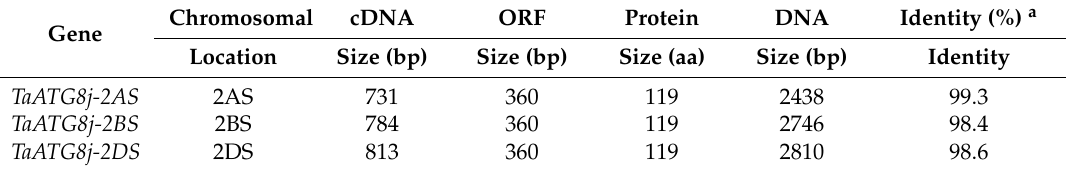
Table 1. Three copies of TaATG8j in the subgenomes of wheat encoding the same TaATG8j protein isolated from the Triticum aestivum cv. Chinese Spring genomic database (Available online: http://plants.ensembl.org). Chromosomal cDNA ORF Protein DNA Identity (%) a Gene Location Size (bp) Size (bp) Size (aa) Size (bp) Identity TaATG8j-2AS 2AS 731 360 119 2438 99.3 TaATG8j-2BS 2BS 784 360 119 2746 98.4 TaATG8j-2DS 2DS 813 360 119 2810